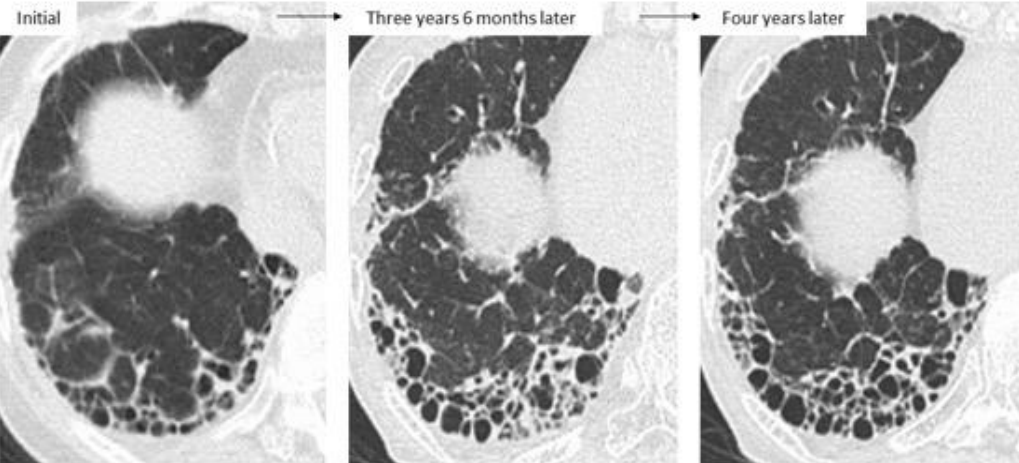
Figure 10. A patient who received sulfasalazine monotherapy for RA. Afterward, UIP-like lesions appearing as reticulations and honeycombing extended with worsening of the patient’s respiratory symptoms, and wall thickening in the areas of honeycombing were also present at 3 years and 6 months after the initial image. After two courses of pulse dose methylprednisolone followed by low-dose prednisolone, wall thickening had improved by six months later.